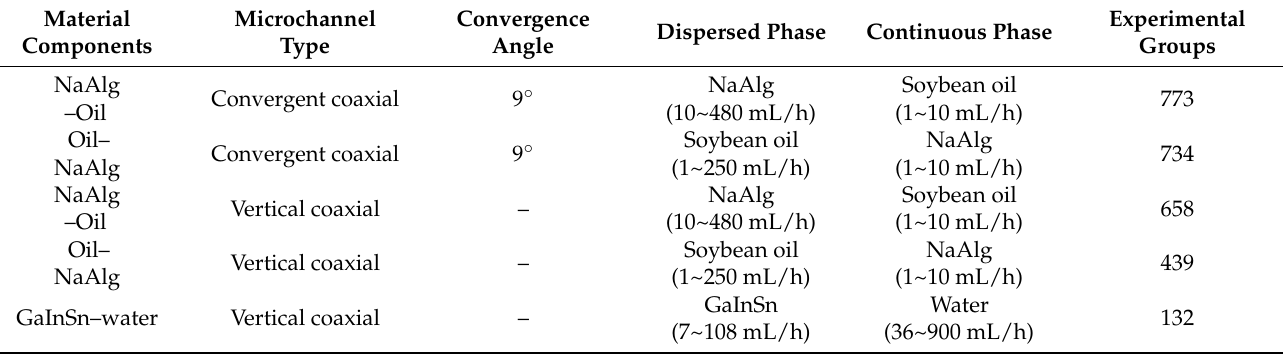
Table 1. Experiment parameters of two-phase